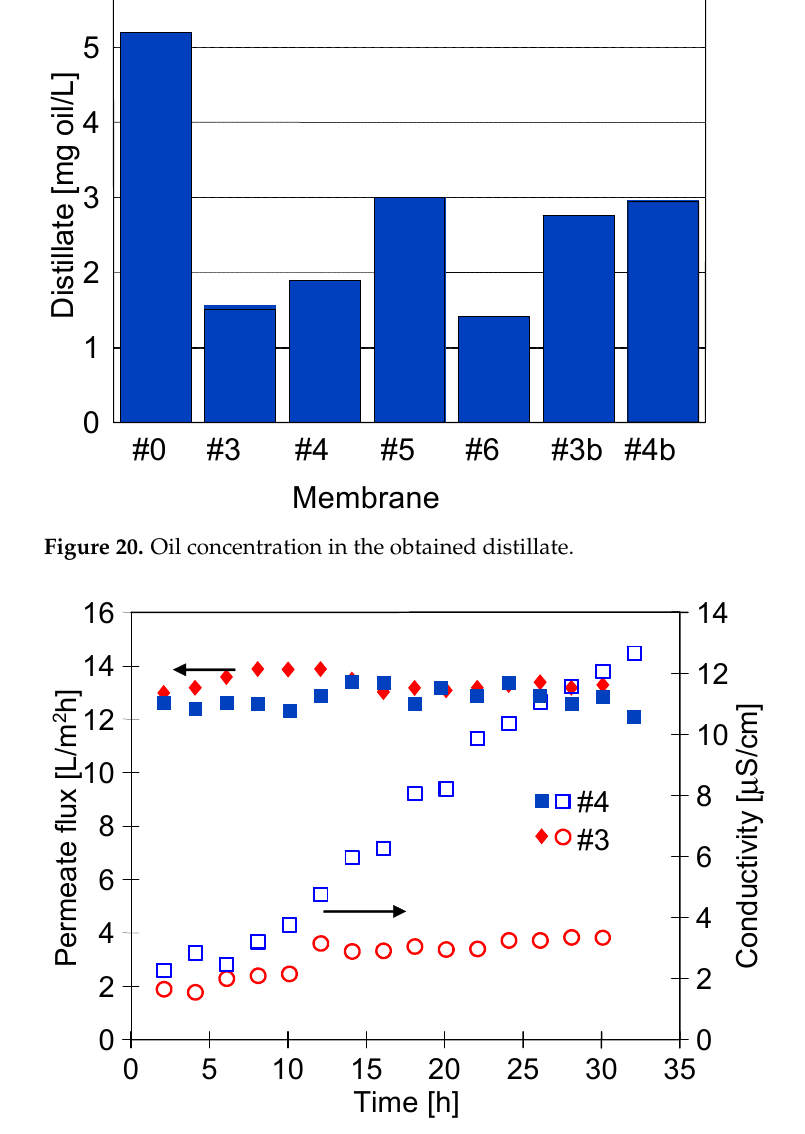
Figure 21. Changes in the permeate flux and conductivity during the long-MD of feed contaminated by oil. Feed: NaCl solution (4 g/L) with oil emulsion (100 ± 20 mg/L).